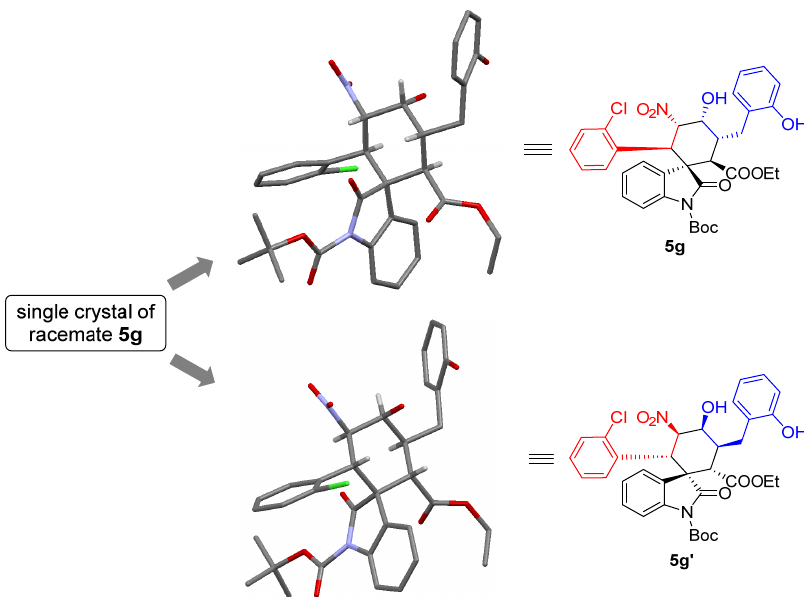
Figure 1. X ‐ ray crystal structure of racemate 5g and the hydrogen atoms (except those of the chiral centers) are omitted for clarity.